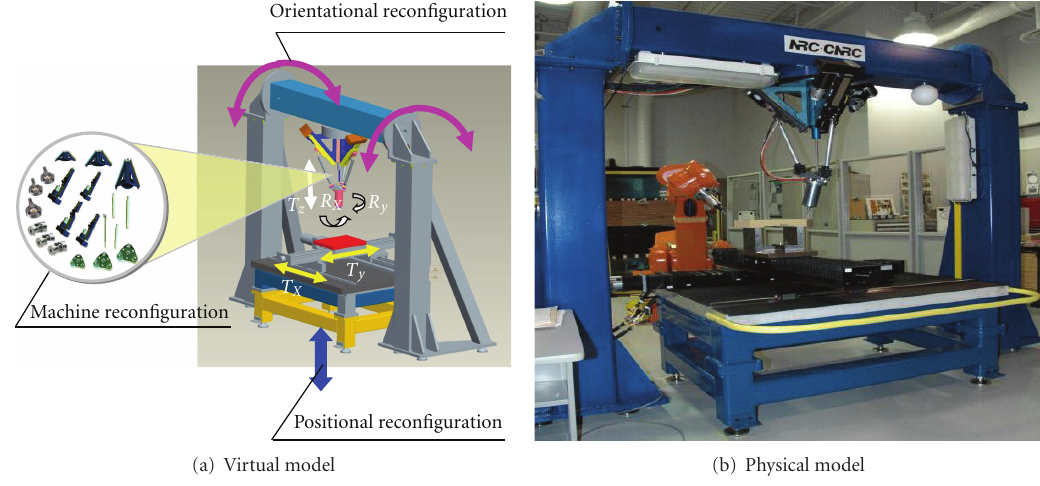
Figure 1: Virtual and physical models of 5-axis machine